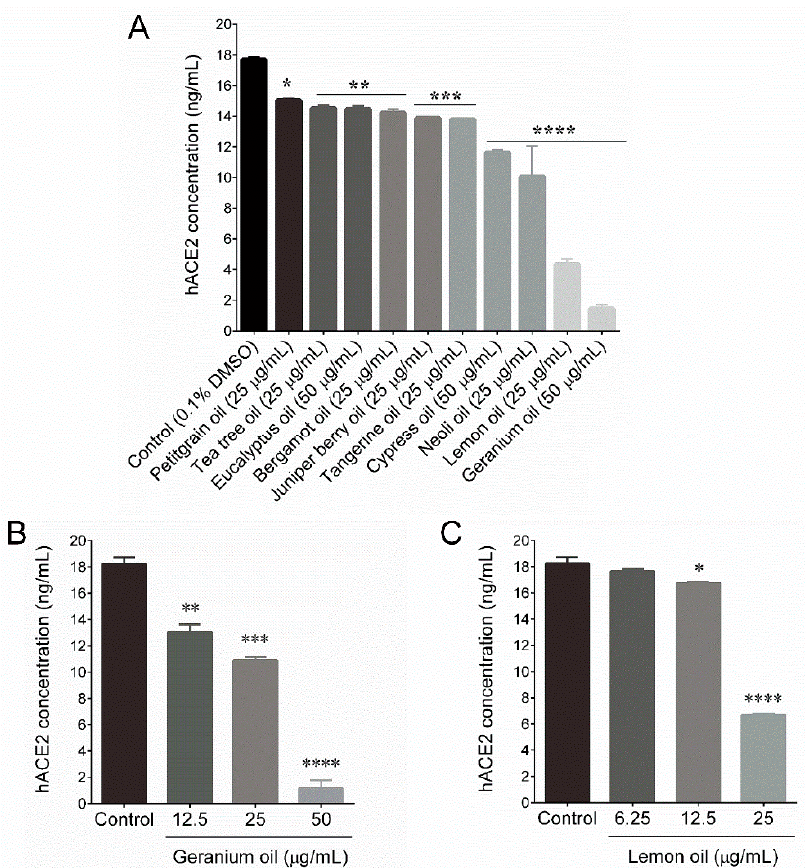
Figure 1. Essential oils reduced human angiotensin-converting enzyme 2 (ACE2) levels in HT-29 cells. ( A ) The ACE2 inhibitory effects of selected essential oils. HT-29 cells were incubated with indicated concentration of selected essential oils for 48 h. Cell lysates were subjected to determine ACE2 levels using a commercially available ELISA kit. ( B , C ) The dose-dependent inhibitory effects of geranium and lemon essential oils were determined in the same course of time. Values represent the mean ± SD of three independent experiments. p -values of less than 0.05*, 0.01**, 0.001***, and 0.0001**** were considered statistically significant for the sample treatment group vs. the control group.